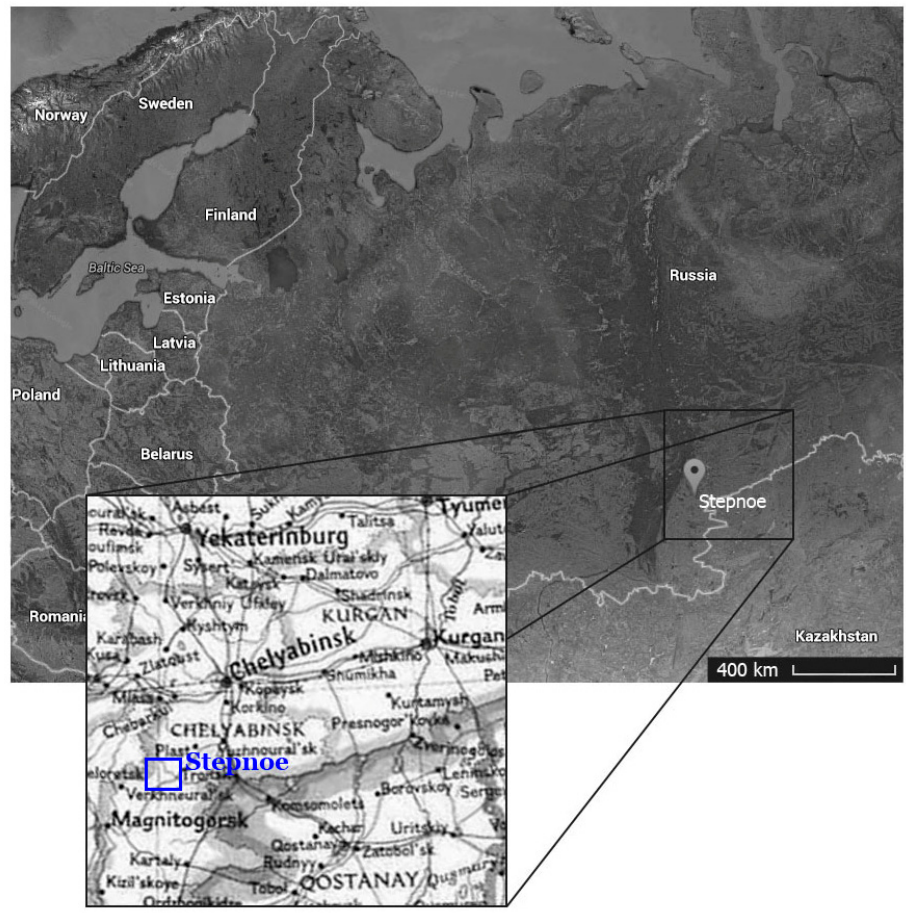
Figure 1. Location of the study area.